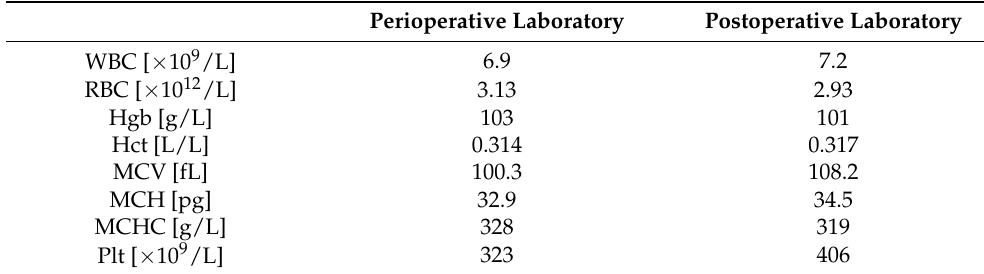
(WBC—white blood count, RBC—red blood cells, Hgb—hemoglobin, Hct—hematocrit, MCV—mean corpus- cular volume, MCH—mean corpuscular hemoglobin, MCHC—mean corpuscular hemoglobin concentration, Plt—platelet